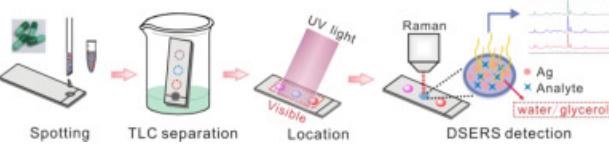
Figure 4: Schematic illustration of TLC-DSERS for on-site detection of antitussive and antiasthmatic drugs adulterated in BDS. Reprinted from Fang et al. (2016) with permission from